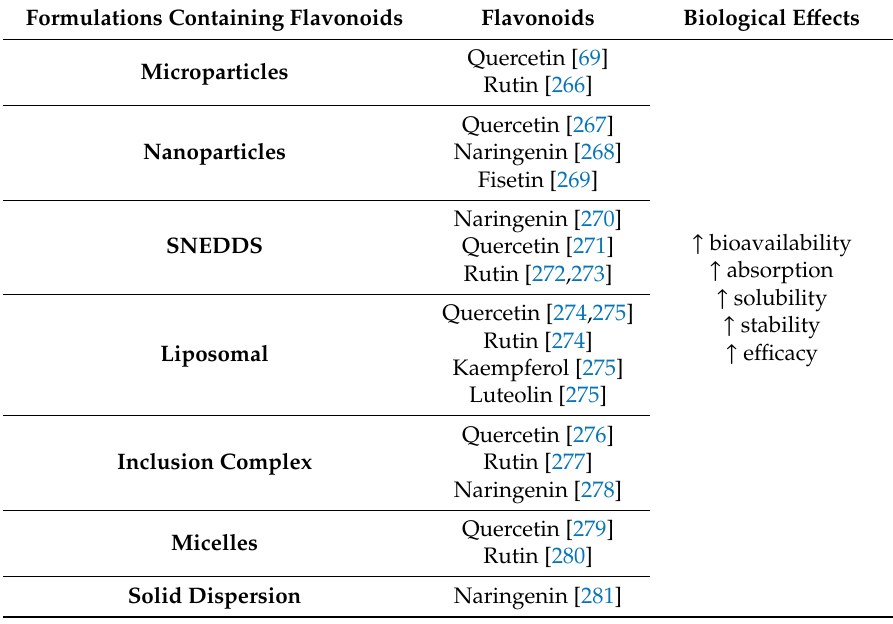
Table 3. Delivery systems containing flavonoids and key improvement e ff